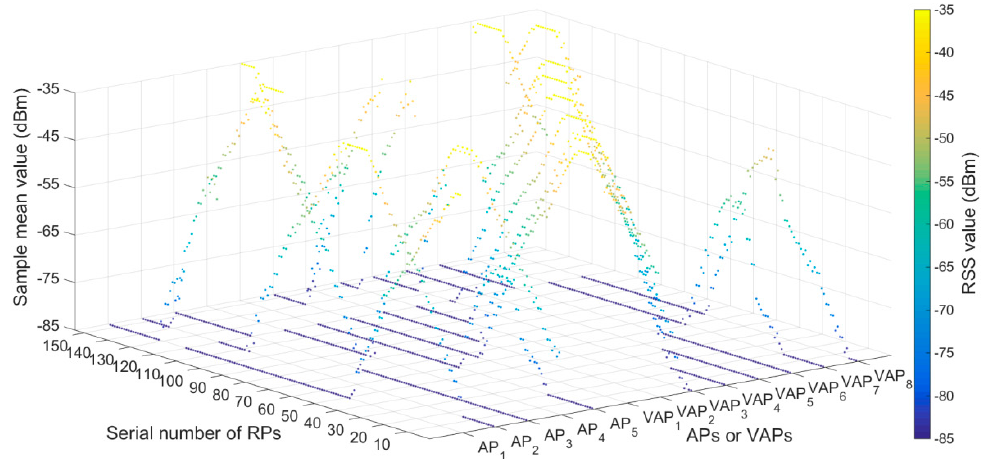
Figure 16. RSS distribution diagram of APs and VAPs at each RPs in experimental environment I.